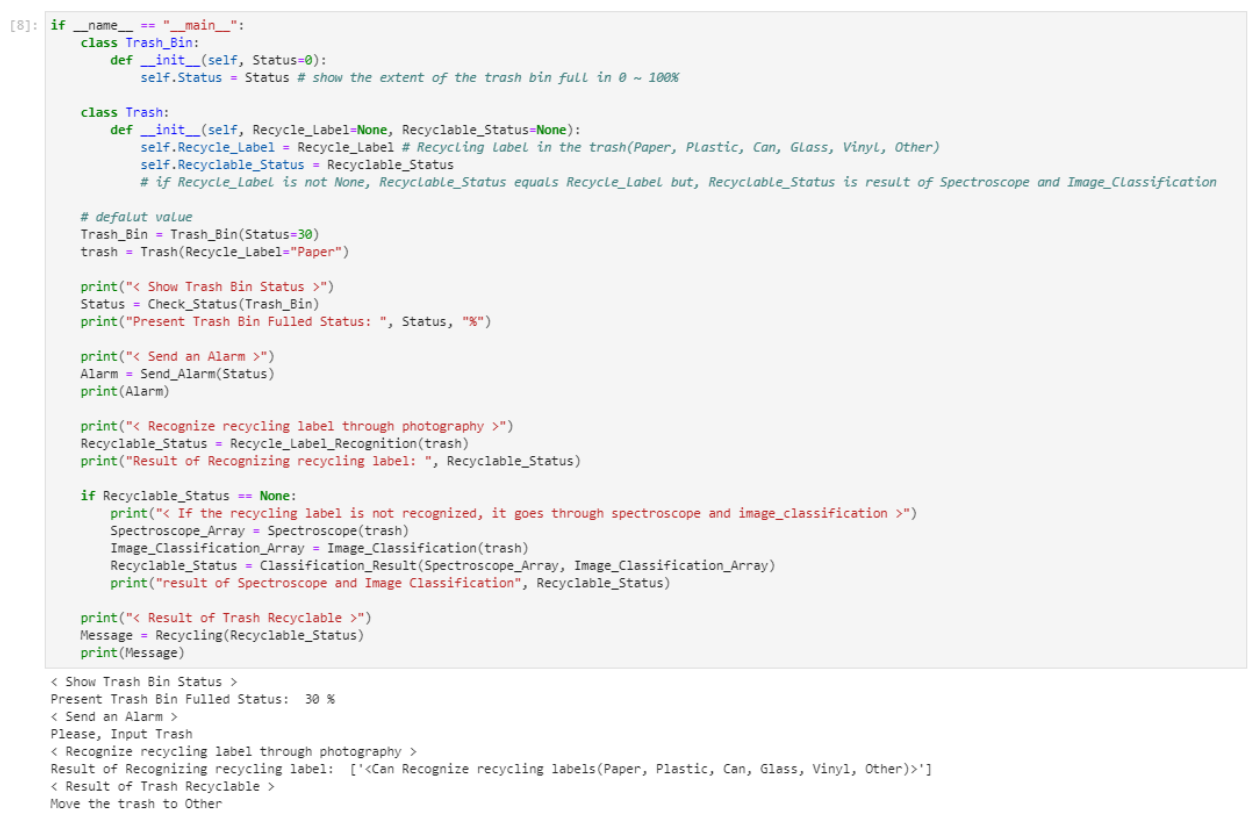
Figure A3. Define Recycle Label Recognition and Classification Process using Python pseudocode.